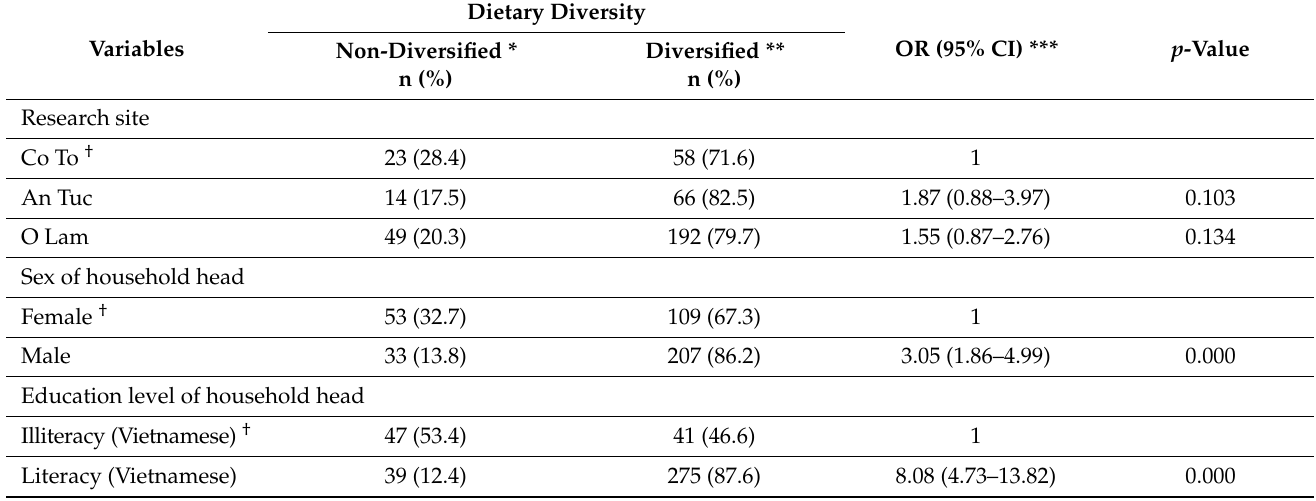
Table 2. Characteristics and univariate analysis of factors associated with Khmer household dietary diversity in Tri Ton district.